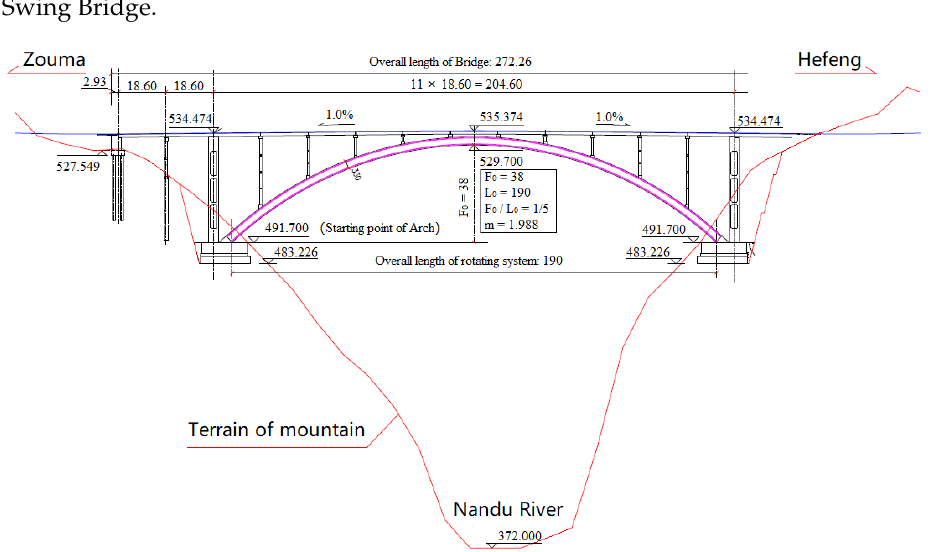
Figure 2. The layout of the Nandu River Swing Bridge (unit: